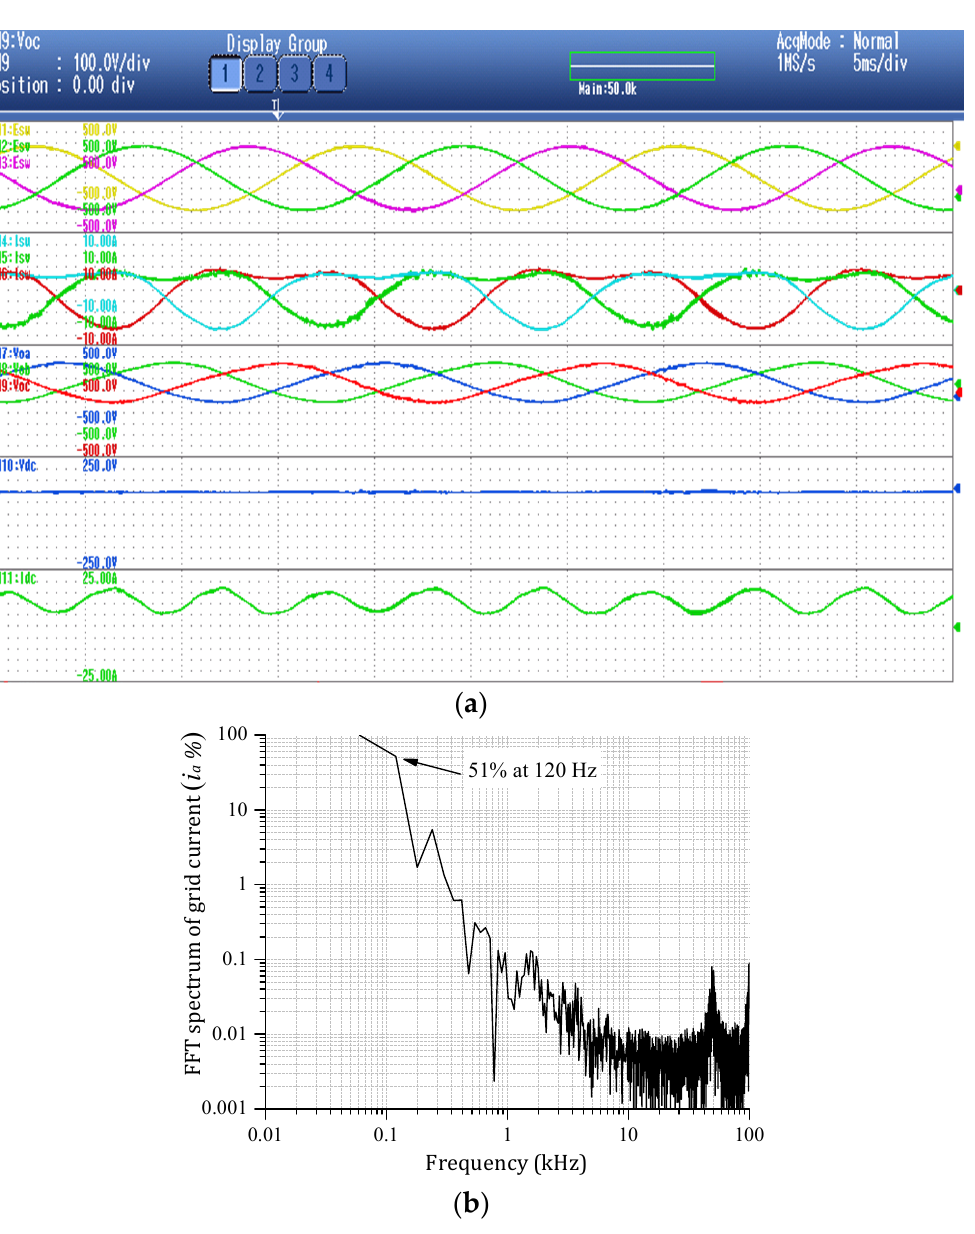
Figure 15. Experimental system results without SOHC compensation. ( a ) Converter results without SOHC compensation. ( b ) Grid current FFT harmonic spectrum without SOHC compensation.